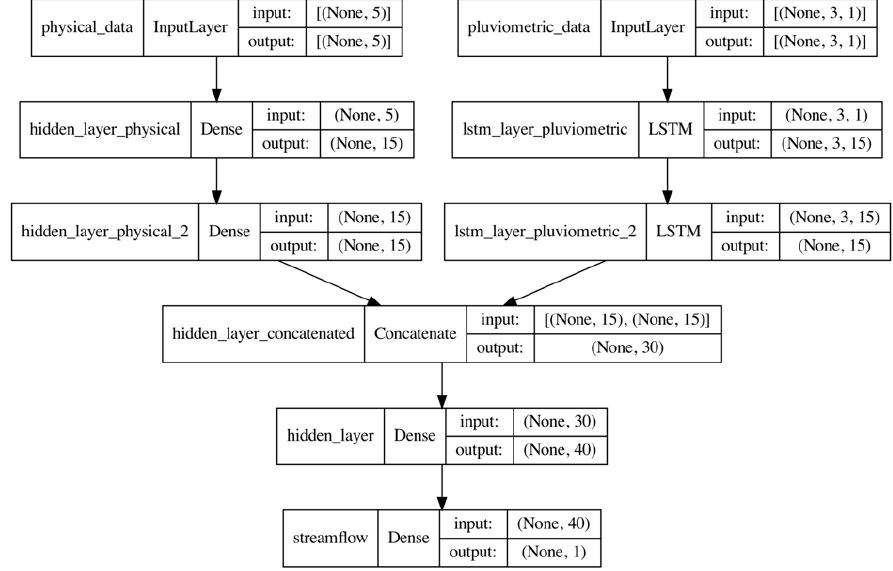
Figure 4. Data processing flowchart for the LSTM model. “None” represents the batch size, which is only decided in the training phase.